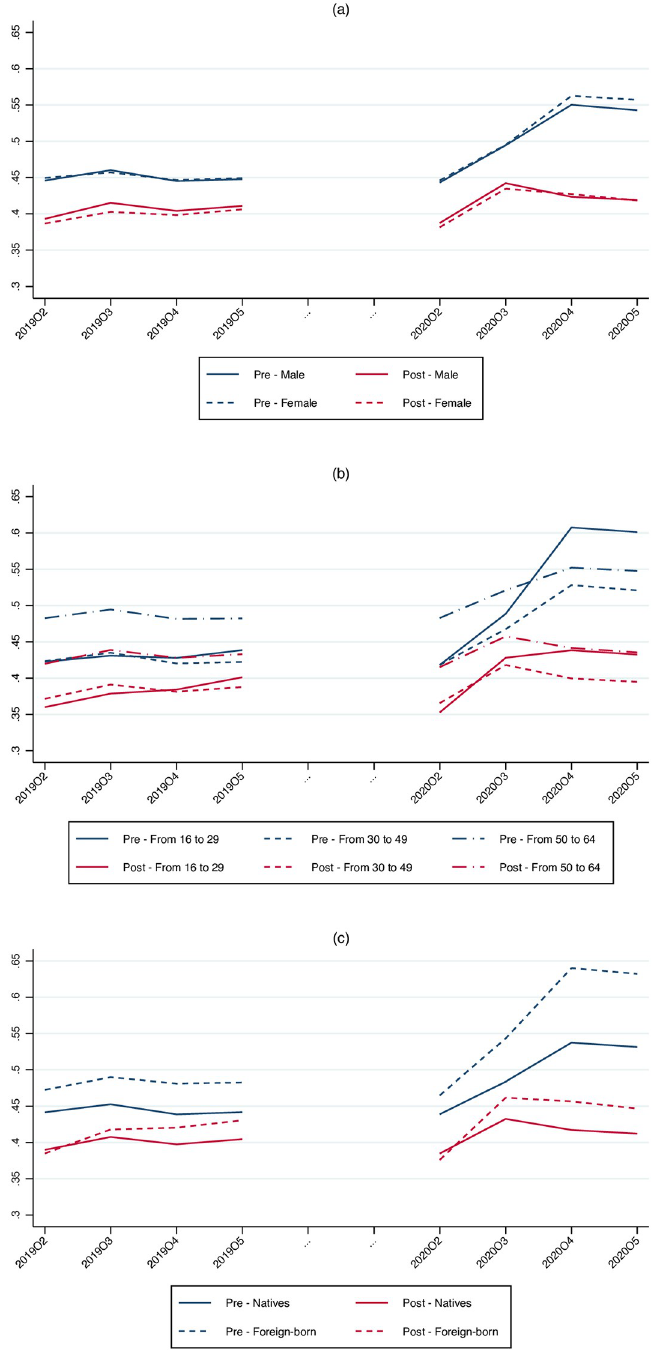
Fig 5. Evolution of the Gini index by gender, age and country of origin. (a) By gender. (b) By age group. (c) By place of birth. Panel (b) of Fig 5 shows the evolution of inequality for different age groups. For the youn- gest cohort (i.e., 16 to 29 years old), there is a considerable increase in the Gini index for pre- transfer earnings. The other groups also experience an increase in inequality though much smaller than for the young. The spike in the Gini index for the young is mitigated when